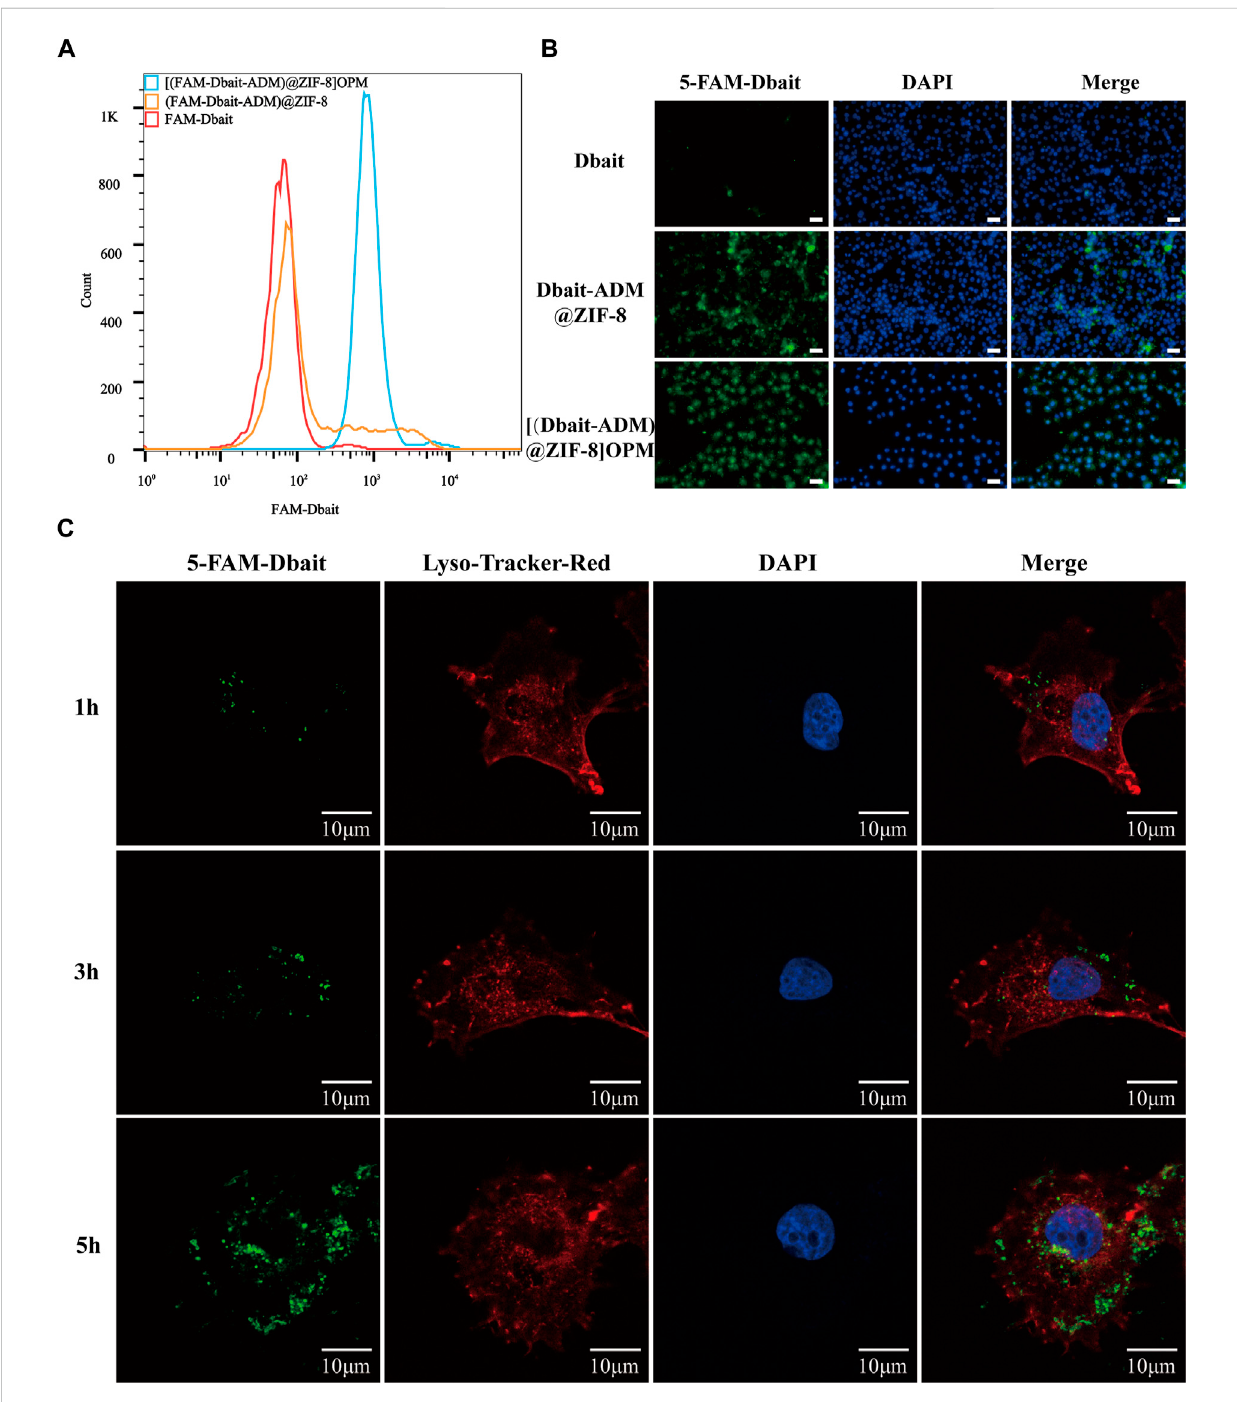
FIGURE 4 In vitro targeting capability of [Dbait-ADM@ZIF-8]OPM. (A) Cellular uptake of free Dbait, Dbait-ADM@ZIF-8, [Dbait-ADM@ZIF-8]OPM was analyzed by fl ow cytometry. (B) Entry of free Dbait, Dbait-ADM@ZIF-8, [Dbait-ADM@ZIF-8]OPM into the cells was observed by fl uorescence microscopy. Scale bar, 50 nm. (C) CLSM images of SaOS-2 cells cultured with [Dbait-ADM@ZIF-8]OPM for 1, 3, and 5 h. Dbait was labeled with 5-FAM (green), late endosomes and lysosomes were stained with Lyso-Tracker Red (red) and nuclei were stained with DAPI (blue). Scale bar, 10 μ